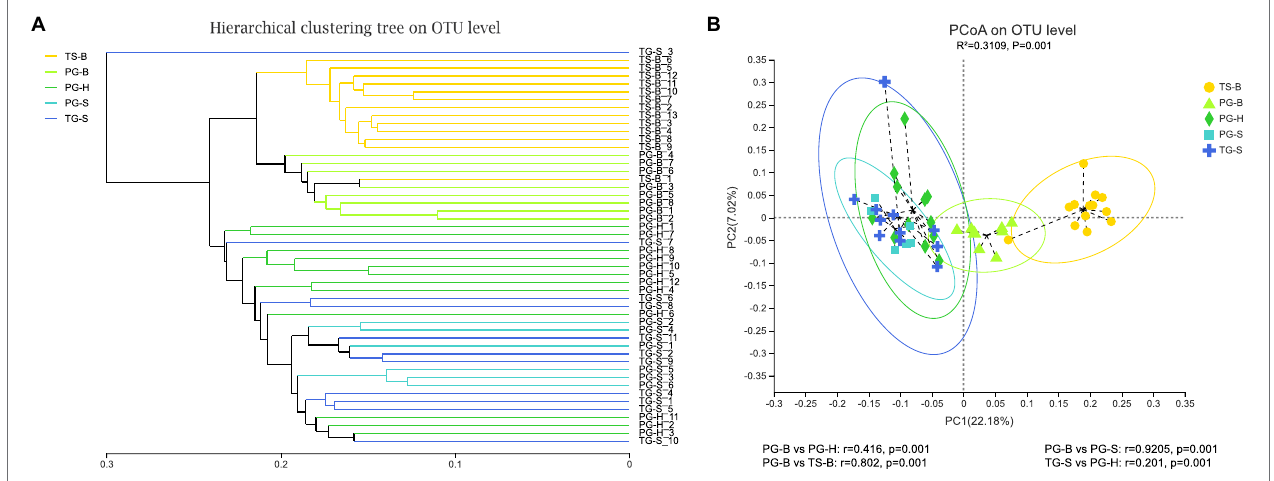
FIGURE 5 | Comparison of the gut bacterial community of the three species from five populations. (A) Clustering analysis of the evolution of the gut bacterial community of the isolated Przewalski’s gazelle in Haergai (PG-H) and sympatric Przewalski’s gazelle (PG-S) and Tibetan gazelle in Shengge (TG-S). The managed population of Przewalski’s gazelles (PG-B) was sympatric and mixed with Tibetan sheep on Bird Island (TS-B). Gut bacterial trees were generated using the unweighted pair group method with arithmetic mean (UPGMA) algorithm based on the unweighted-unifrac distances generated by mothur. The managed PG-B and sympatric Tibetan sheep clustered on the same branch, while three wild gazelle populations clustered together. (B) Principal coordinate analysis (PCoA) of microbial communities. Distances between symbols on the ordination plot reflect relative dissimilarities in community structures. Paired differences of analysis of similarities (ANOSIM) were shown below. Gut bacterial community of managed Przewalski’s gazelle (PG-B) was significantly different with that of their wild relatives.